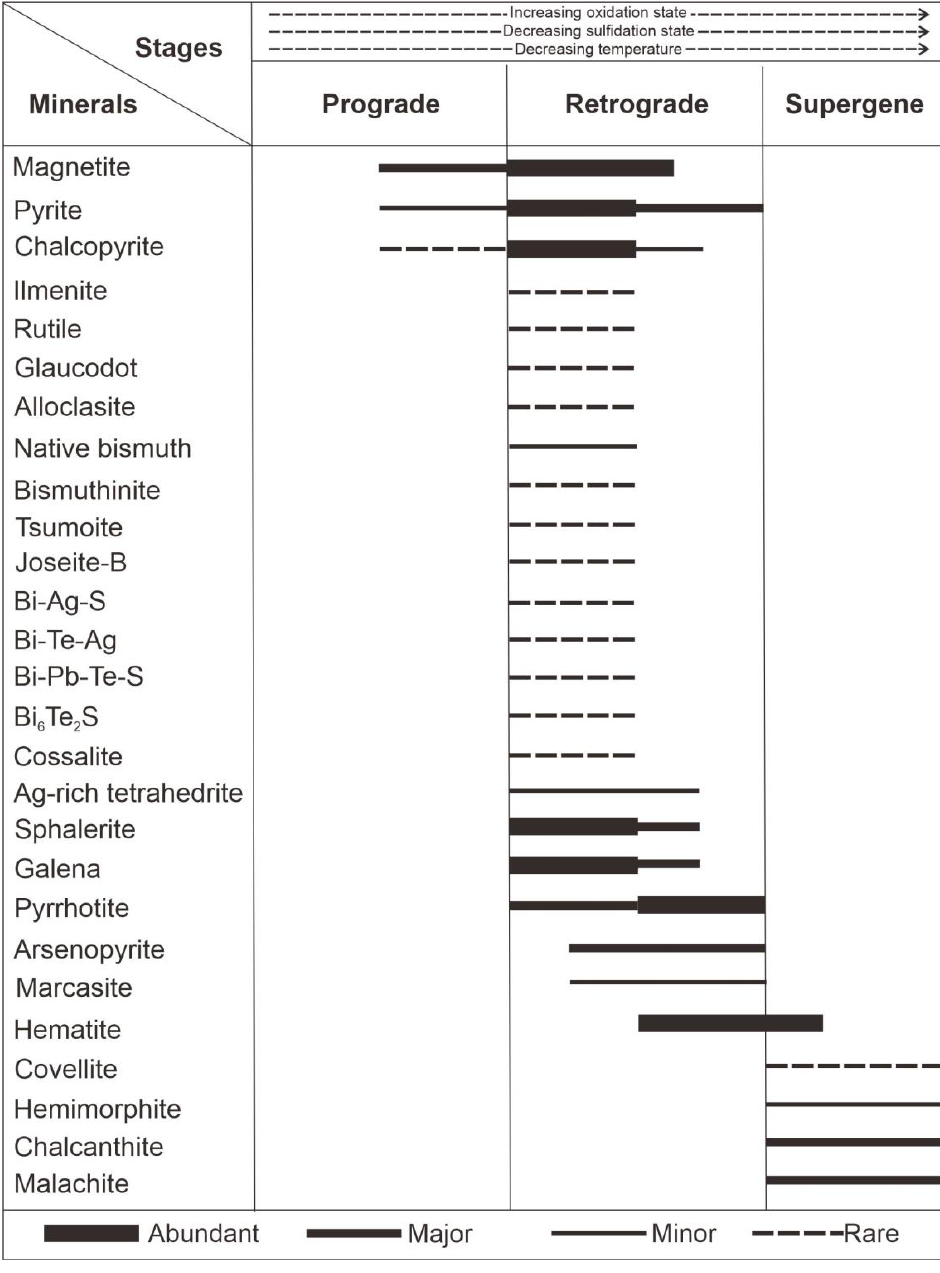
Figure 9. The ore mineral paragenetic sequences of the Ruwai skarn deposit where the main mineralization stage occurred during the retrograde stage.